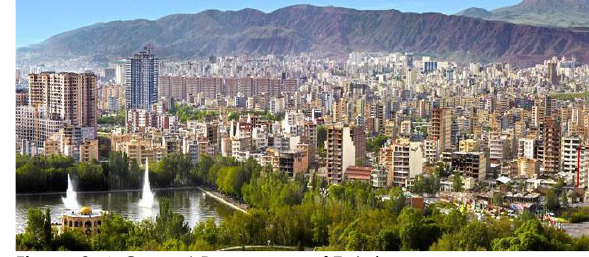
Figure 3. A Current Panorama of